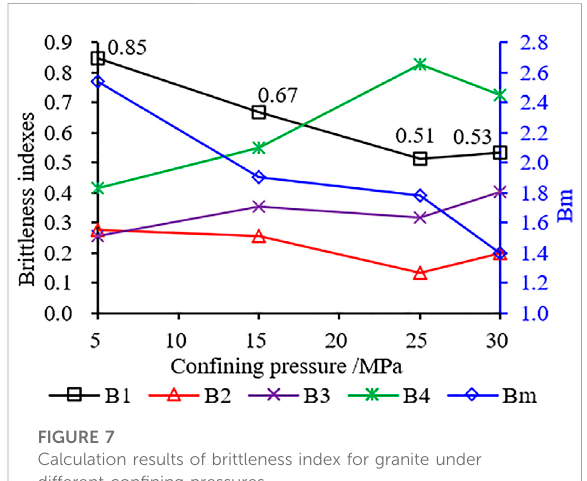
FIGURE 8 Calculation results of brittleness index for sandstone under different con fi ning pressures.